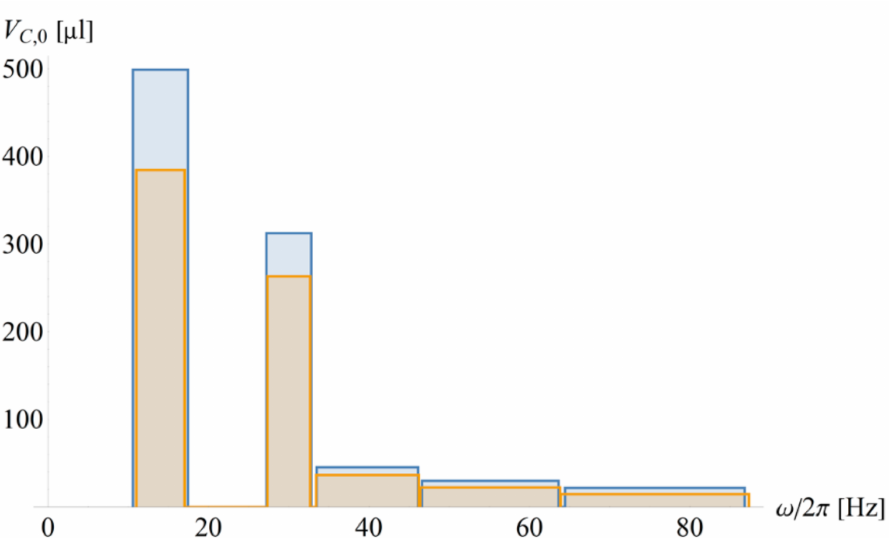
Figure 7. Rotational automation of an exemplary bioassay featuring sequential release of sample and separated plasma as well as pre-stored liquid onboard reagents L1, L2, and L3 with high-pass CP-DF siphon valves of release rates { Ω i } with Ω S /2 π = 15 Hz and Ω P /2 π = 30 Hz. The release rates { Ω } are tuned by the dead volumes of the main compression chamber { V i vertical axis. (a) Radial positions (blue) R i = { 3,4,3.5,3,2.5 } cm and (orange) R (cid:48) concurrent processing of the same bioassay protocols requiring identical { Ω i } for concurrent valving ( M = 3), while increasing their spatial packing density towards microfluidic